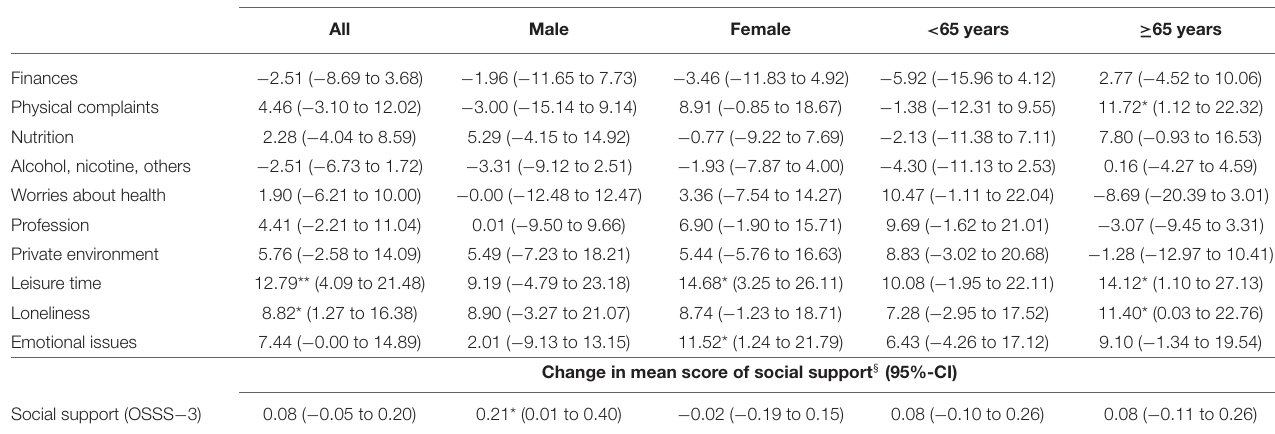
TABLE 3 | Changes in the percentage of hospital inpatients reporting slightly or substantially more distress due to the coronavirus disease 2019 (COVID-19) pandemic in specific life areas and changes in perceived social support from periods of modest to strong COVID-19 restrictions, based on linear regression models, stratified by sex and age group ( N =